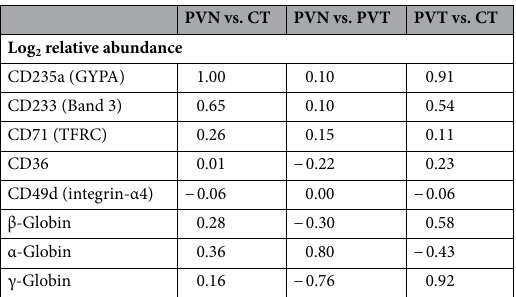
PVN vs. CT PVN vs. PVT PVT vs.